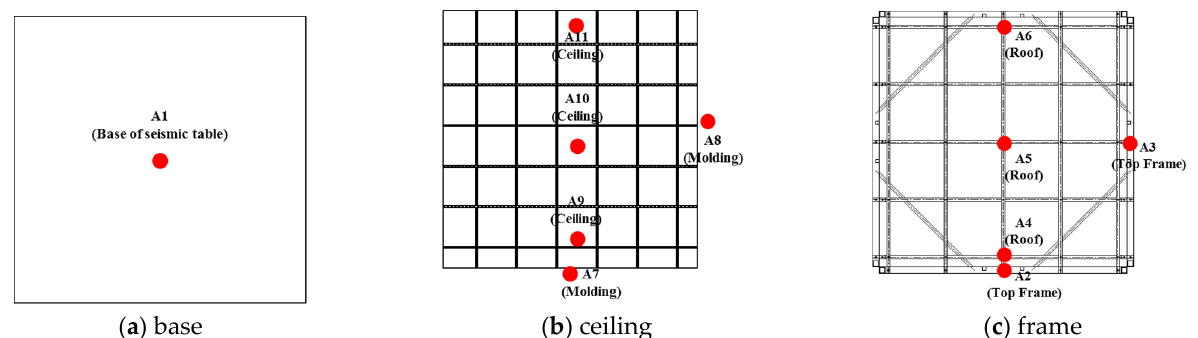
Figure 8. Test frame for shaking table test.